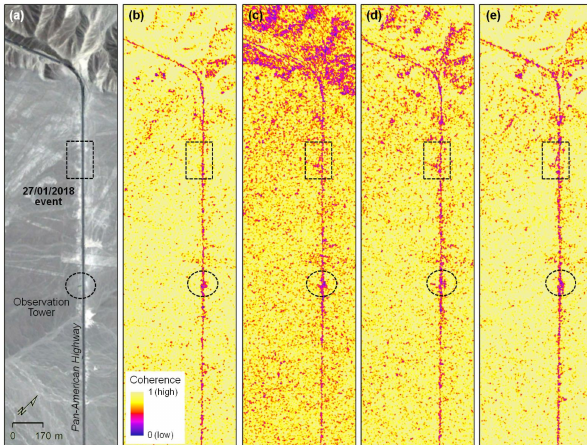
Figure 3. Analysis of the 27/01/2018 event: ( a ) Google Earth overview of the Pan-American Highway (VHR image © 2018 DigitalGlobe), with the locations of the event and Observation Tower marked by the dashed rectangle and oval, respectively; and ( b – e ) InSAR coherence γ for a series of COSMO-SkyMed StripMap pairs: ( b ) 18/01/2018–26/01/2018 (pre-event); ( c ) 26/01/2018–30/01/2018 (cross-event); ( d ) 10/01/2018–30/01/2018 (cross-event); and ( e ) 13/12/2017–30/01/2018 (cross-event).